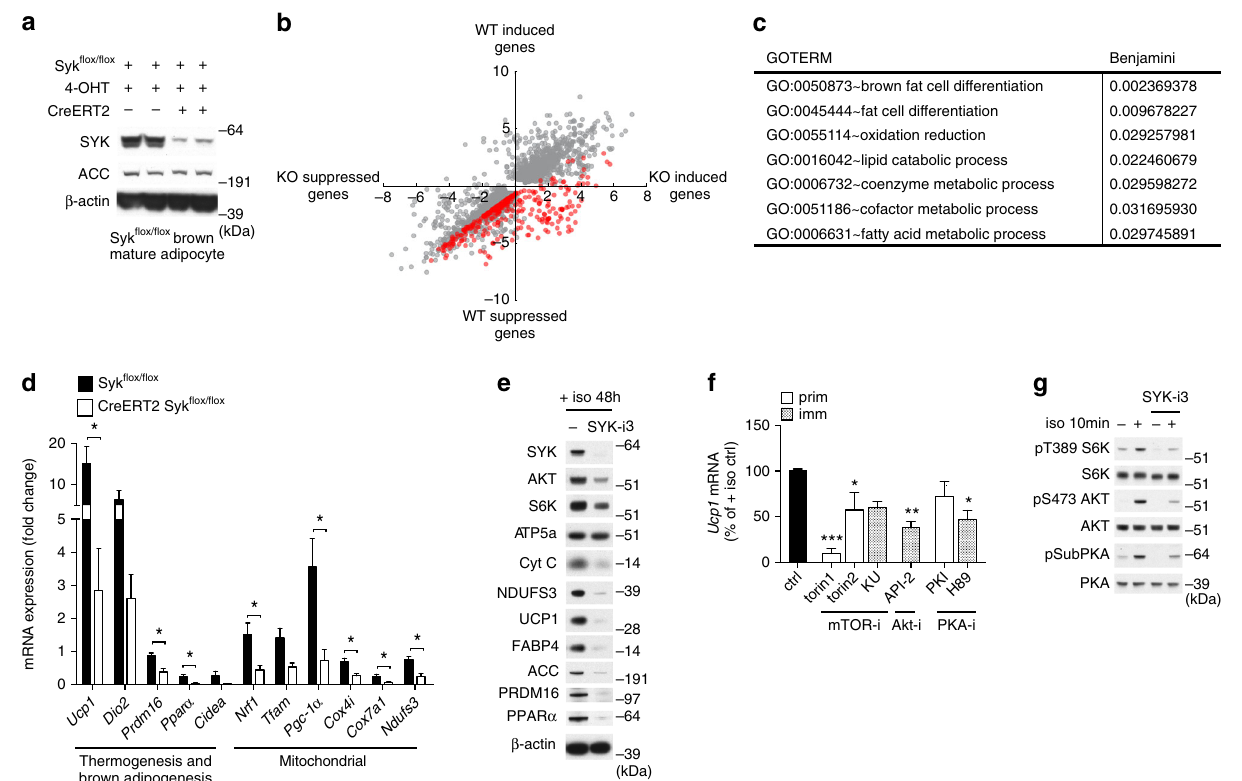
Fig. 2 SYK mediates expression of characteristic brown fat genes and activates the AKT/mTOR pathway. a Representative immunoblots of SYK protein expression from three independent differentiations of in vitro differentiated brown adipocytes from CreERT2 Syk fl ox/ fl ox mice on day 8 of differentiation following continuous treatment with 4-hydroxy tamoxifen (4-OHT) for 9 days. b RNA-seq was conducted on 3 replicates of 4-OHT treated Syk fl ox/ fl ox (WT) and CreERT2 Syk fl ox/ fl ox (KO) cells as shown in a before and after isoproterenol treatment at day 8 of differentiation. Log fold change in WT cells before and after induction is shown on the x axis and log fold change in KO cells before and after induction is shown on the y axis. Genes shown had at least a 1.5-fold up- or down-regulation in WT or KO cells after stimulation with an FDR < 0.05. Genes with a fold change difference of 1.5 higher in WT compared to KO with a p value < 0.05 are shown in red. c Enriched GO categories with a Benjamini adjusted p value < 0.05 for genes shown in red in b . d Fold change of mRNA expression in day 8 differentiated primary brown adipocytes with tamoxifen-induced reduction in SYK protein as described in ( a ) and stimulated with isoproterenol. e Representative immunoblots of two independent experiments of primary brown adipocytes stimulated with isoproterenol on day 8 of differentiation for 48 h in complete medium in the presence or absence of 5 μ M SYK-i3. f Day 8 differentiated brown adipocytes (prim, primary; imm, immortalized) stimulated with isoproterenol and pretreated with mTORC inhibitors torin 1 (10 μ M), torin 2 (10 μ M) or KU0063794 (10 μ M), AKT inhibitor API-2 (10 μ M), or PKA inhibitors PKI 14-22 (10 μ M), or H89 (10 μ M) ( n = 3). g Representative immunoblots of three independent experiments of day 8 primary brown adipocytes pretreated with 5 μ M SYK-i3 and stimulated with isoproterenol for 5 min. pPKAsub, antibody recognizing PKA substrate phosphorylation motif RRXS*/T*. For f , mean % ± SEM and d , fold change vs unstimulated control ± SEM was calculated. For d , two-tailed